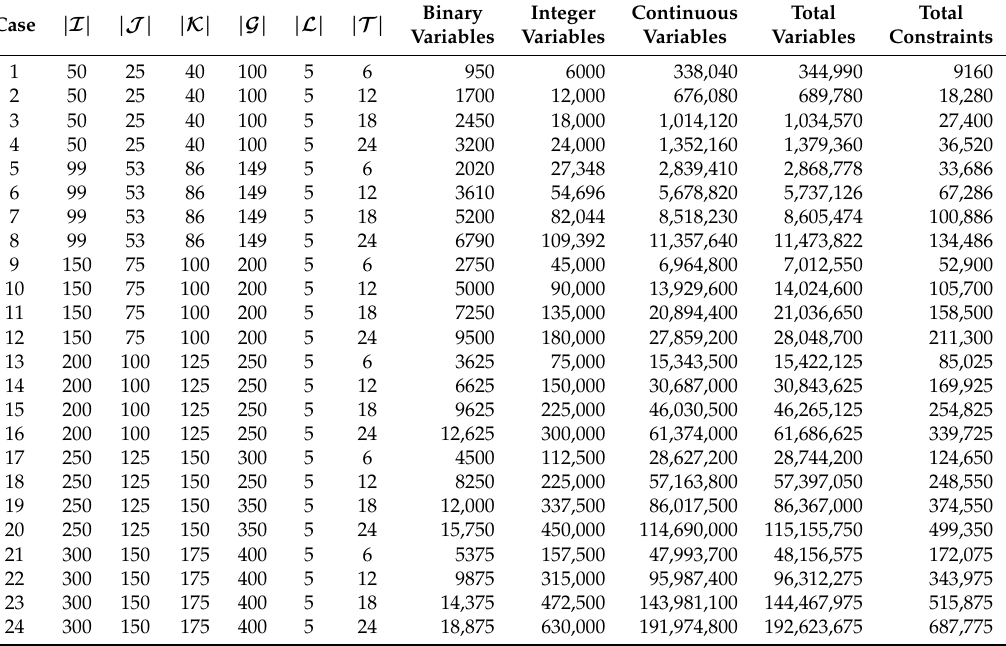
Table 4. Problem size of the test instances.